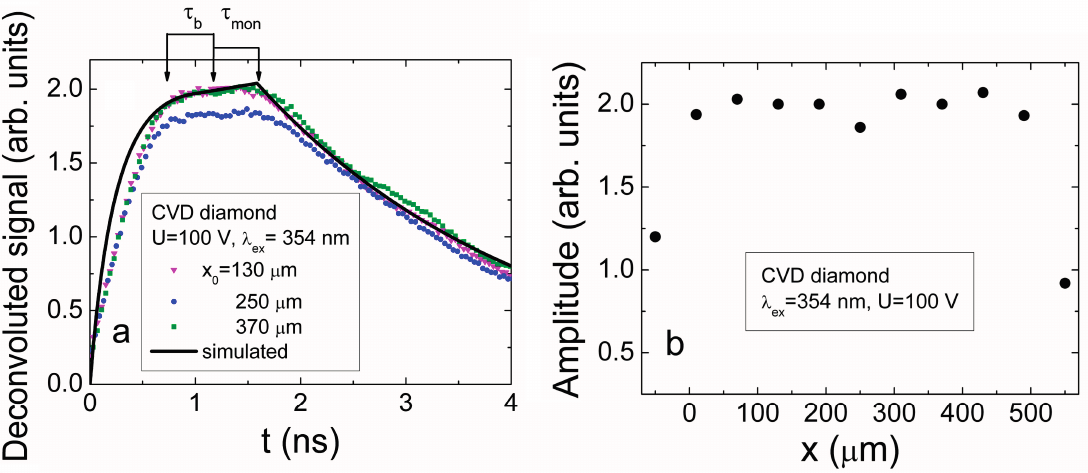
Figure 16. ( a ) The deconvoluted current transients for several injection positions recorded within cross-sectional scans of the CVD diamond capacitor type detector. The bipolar ( τ b ) and monopolar ( τ mon ) drift components are denoted by arrows for drift of electrons within the final phase of transient. The solid curve represents a simulated transient for injection location x = 130 μ m relatively to the negative electrode at voltage U bias DC = 100 V; ( b ) The amplitude of the induced current (ascribed to the bipolar drift component) as a function of the injection position within inter-electrode gap, measured in capacitor type detector made of CVD